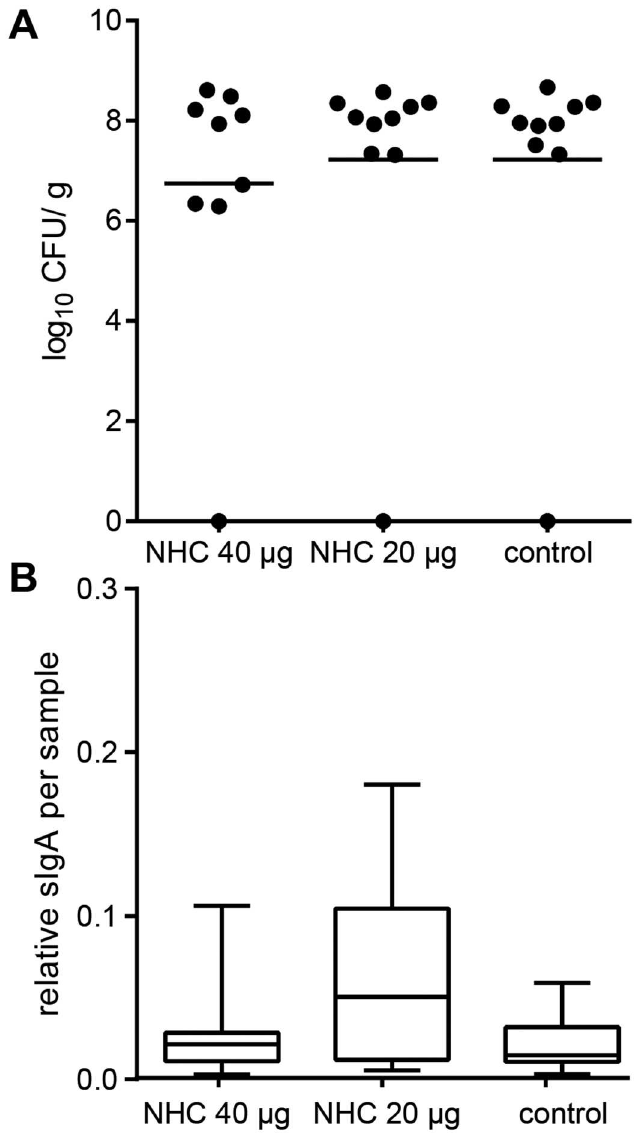
Fig 6. Cecal colonization of C . jejuni and sIgA responses in vaccinated and control chickens. ( A ) Chickens were challengedwith C . jejuni at 18 day of age. One week post-inoculation (25 days of age) the number C . jejuni in the ceca was determinedby plate counting (CFU/ g). Each symbol represents one chicken of the indicatedgroups, bars represent the mean number of log 10 CFU/ g per group. ( B ) Antigen- specific sIgA in 20-times diluted cecal content from 25 day-old chickens (one week after C . jejuni challenge) as determined by ELISA. Graphs represent the analysisof individualanimals of each of the indicatedgroups, displayedas a box-and-whisker